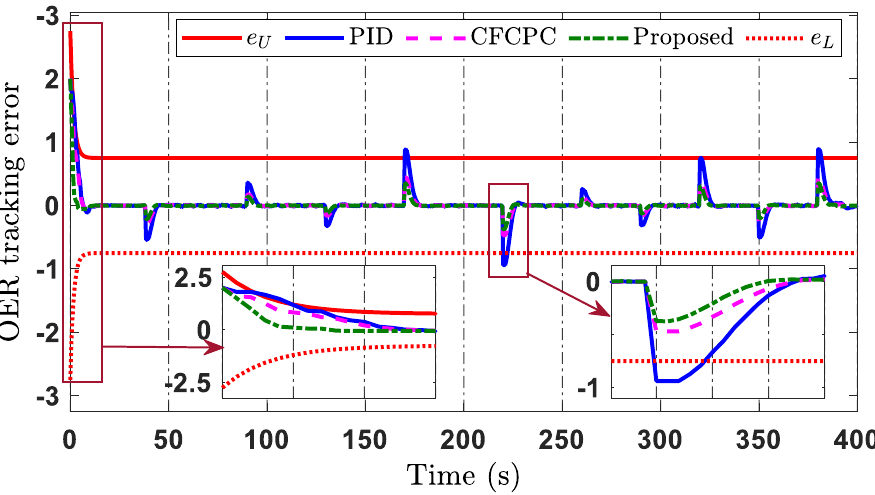
Figure 11. Performance tracking error of the proposed and comparative controllers in the experiment.